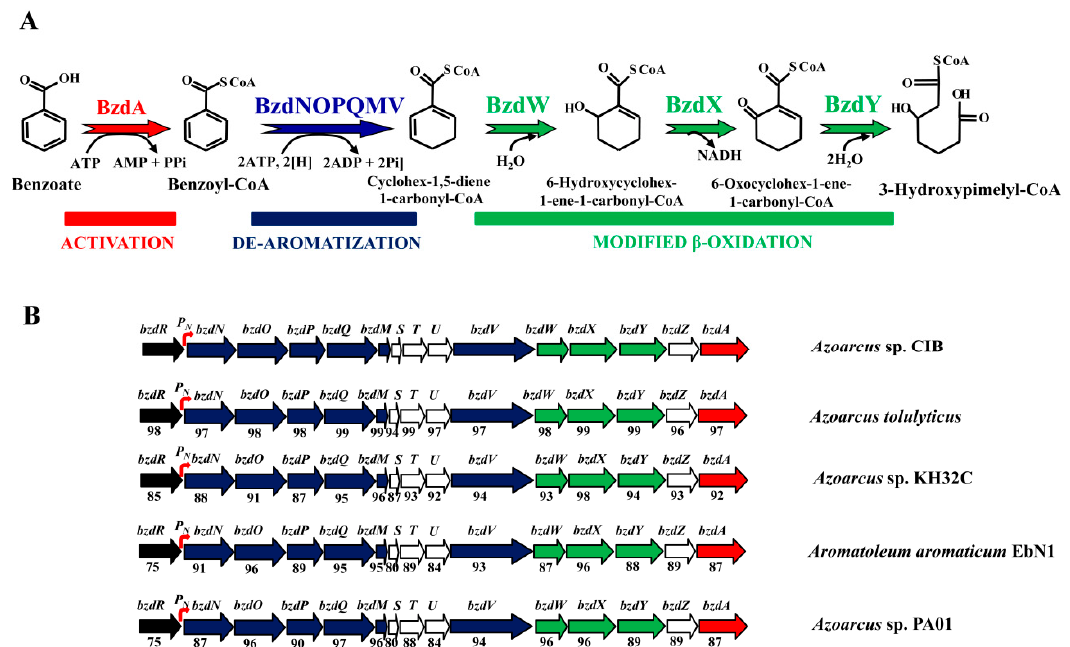
Figure 1. Scheme of anaerobic degradation of benzoate and gene organization of the bzd cluster in di ff erent Azoarcus and Aromatoleum strains. ( A ) Scheme of the anaerobic degradation pathway of benzoate into benzoyl-CoA (red), the de-aromatization of benzoyl-CoA (blue), and the modified β -oxidation that produces 3-hydroxypimelyl-CoA. Enzyme abbreviations: BzdA, benzoate-CoA ligase; BzdNOPQMV, benzoyl-CoA reductase, ferredoxin, and putative reduced nicotinamide adenine dinucleotide phosphate (NADPH)::ferredoxin oxidoreductase; BzdW, cyclohex-1,5-diene-1-carbonyl-CoA hydratase; BzdX, 6-hydroxycyclohex-1-ene-1-carbonyl-CoA dehydrogenase; BzdY, 6-oxocyclohexene-1-ene-carbonyl-CoA hydrolase. ( B ) Scheme of the bzd cluster in di ff erent Azoarcus / Aromatoleum strains. Genes are indicated in the same color code as the corresponding enzymes in panel ( A ), i.e., genes encoding the activation, de-aromatization, and modified β -oxidation are indicated in red, blue, and green color, respectively. The bzdR regulatory gene is shown in black, and the catabolic P N promoter is shown in red as a curved arrow. Genes of unknown function are colored in white. Below each gene, the percentage of the amino-acid sequence identity to the corresponding Azoarcus sp. CIB ortholog is indicated. The accession numbers of the corresponding genome sequences are as follows: Azoarcus sp. CIB (CP011072), Azoarcus sp. KH32C (AP012304), Aromatoleum aromaticum EbN1 (CR555306), Azoarcus tolulyticus strain ATCC51758 (NZ_FTMD00000000), and Azoarcus sp. PA01